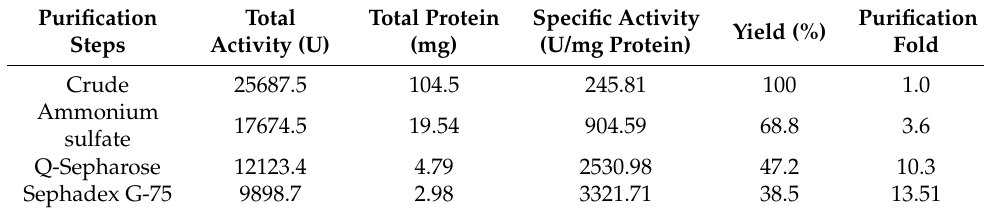
Table 2. Summary of purification of xylanase from Bacillus paramycoides